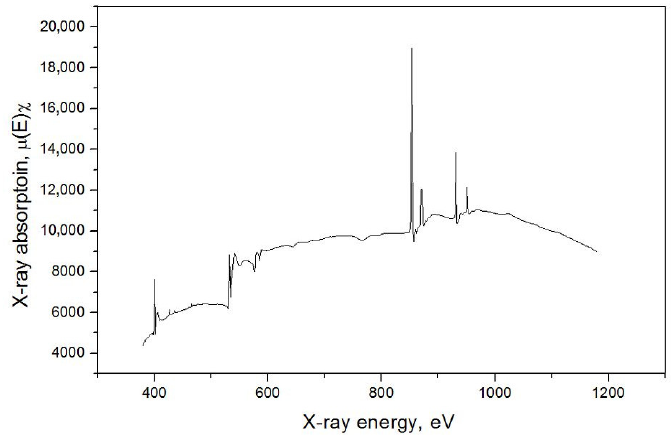
Figure 7. The XAS spectra of [{Cu(pn) 2 } 2 Ni(NCS) 6 ] n ·2nH 2 O ( 1 ).